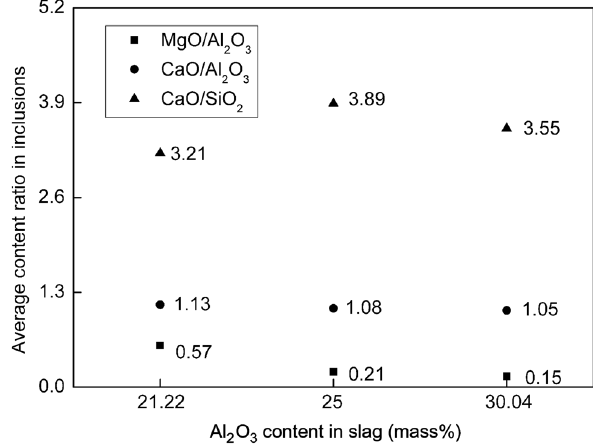
Figure 7 : The relationship between average content ratio of inclusions and Al 2 O 3 content in